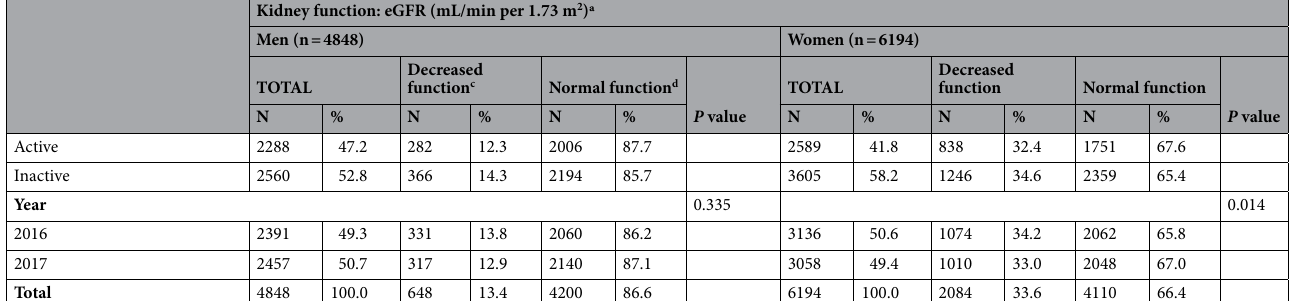
Table 1. General characteristics of the study population. ªGlomerular filtration rate for the Korean population, estimated using the Modification of Diet in Renal Disease equation (mL/min per 1.73 m 2 ) = 107.904 × (Creatinine in mg/dL) −1.009 × (age) −0.02 × 0.667 [if female]. b Q1: < 4.80 mg/dL, < 3.70 mg/dL; Q2: